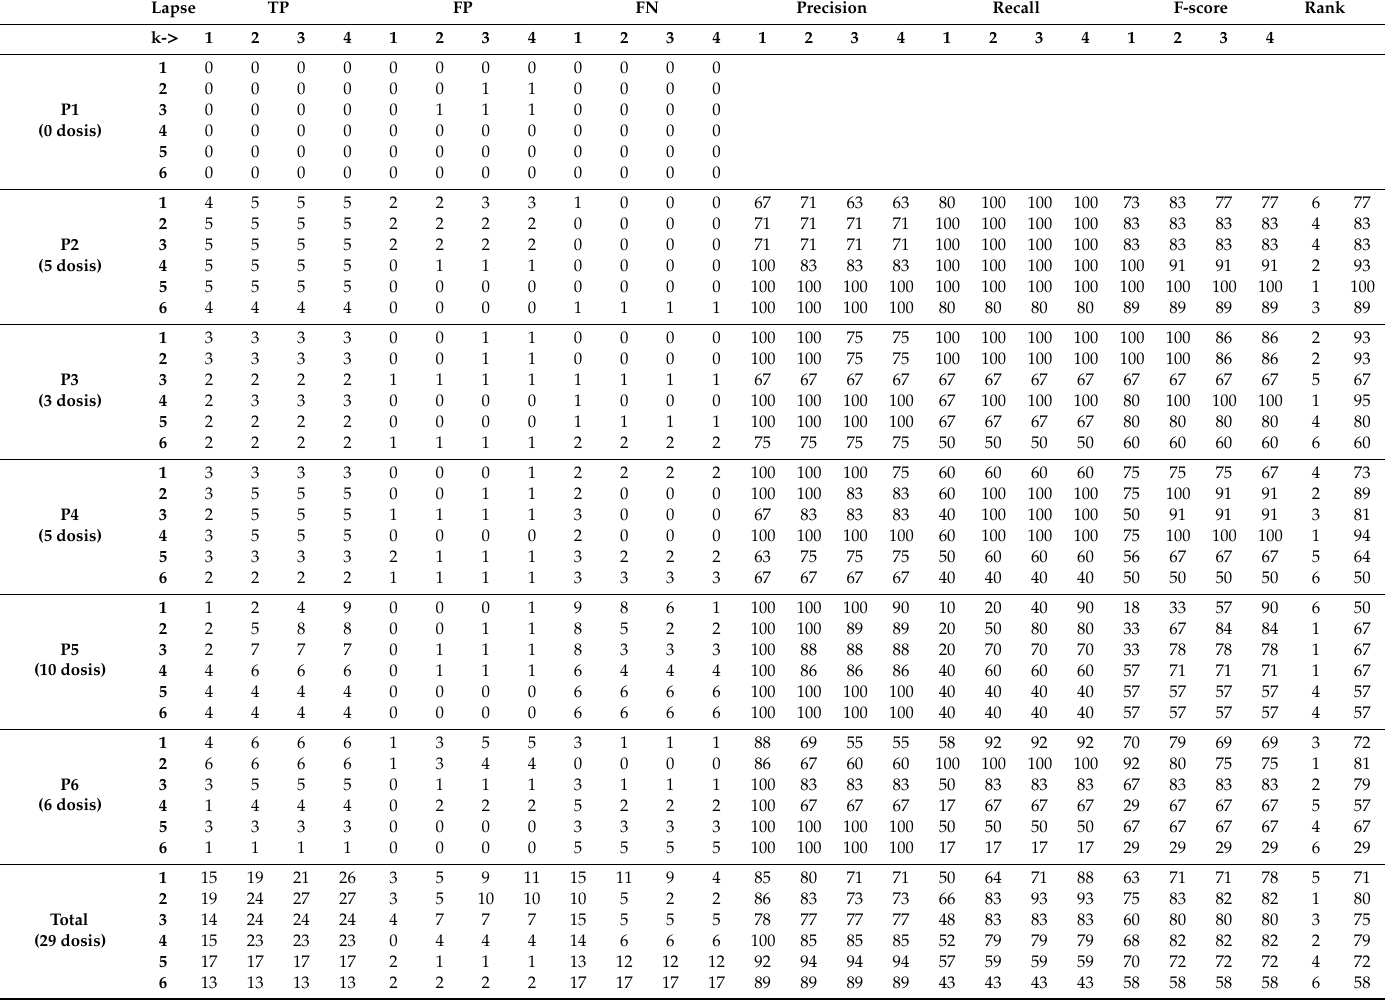
Table 3. Irrigation detection scores using SSM Sentek with 1–6 day intervals (rows), with k ranging from 1 to 4 (columns). The last six rows are the scores for the total number (29) of observed irrigation